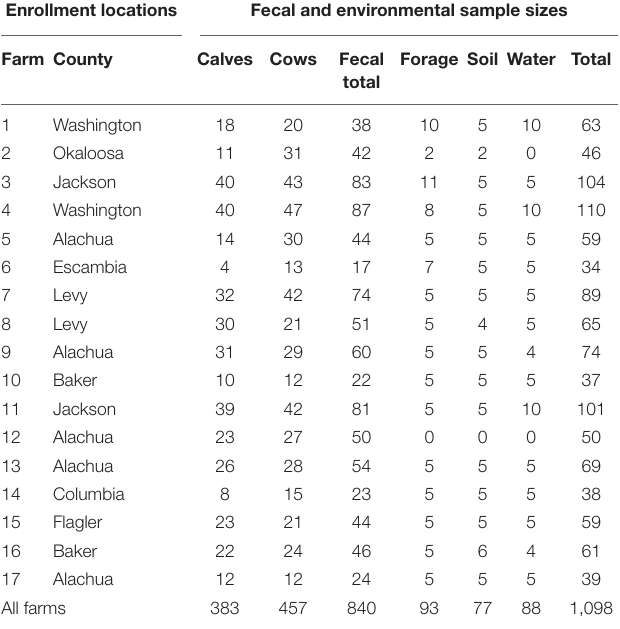
FIGURE 1 | Study location and sample origin. The study enrollment locations included 17 farms from 9 counties across North and Central Florida, United States. The farms appear (red circles) relative the state and county boundaries of Florida. TABLE 1 | Farm identification and sample